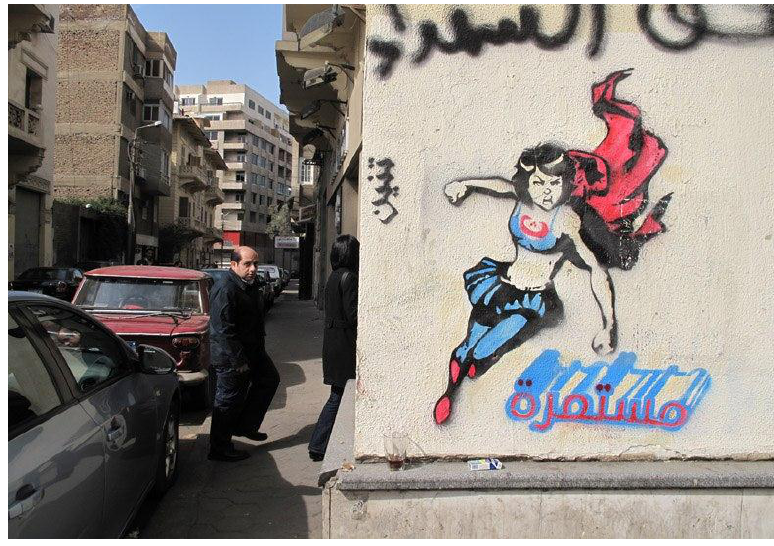
Figure 5. El-Teneen, Supergirl Blue Bra, Heliopolis, Cairo, 2011.